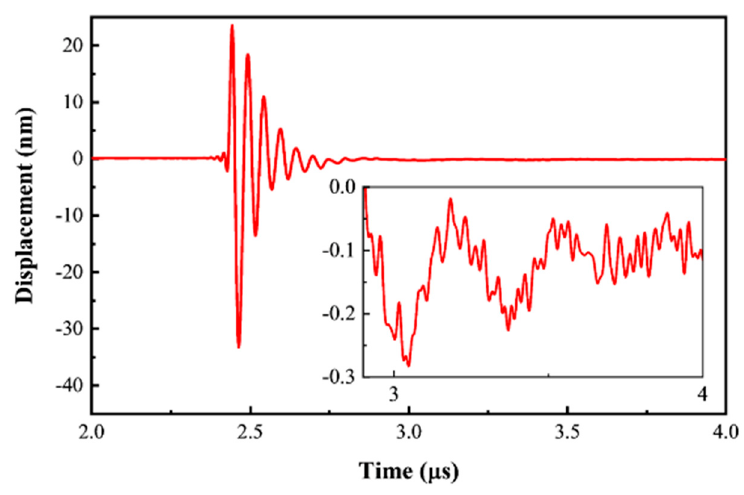
Figure 6. Peak displacement at the center of a B-PDMS element tested in air with a 10 ns 30 V pulse. The insert figure shows the detailed response from 2.9 to 4 µs.